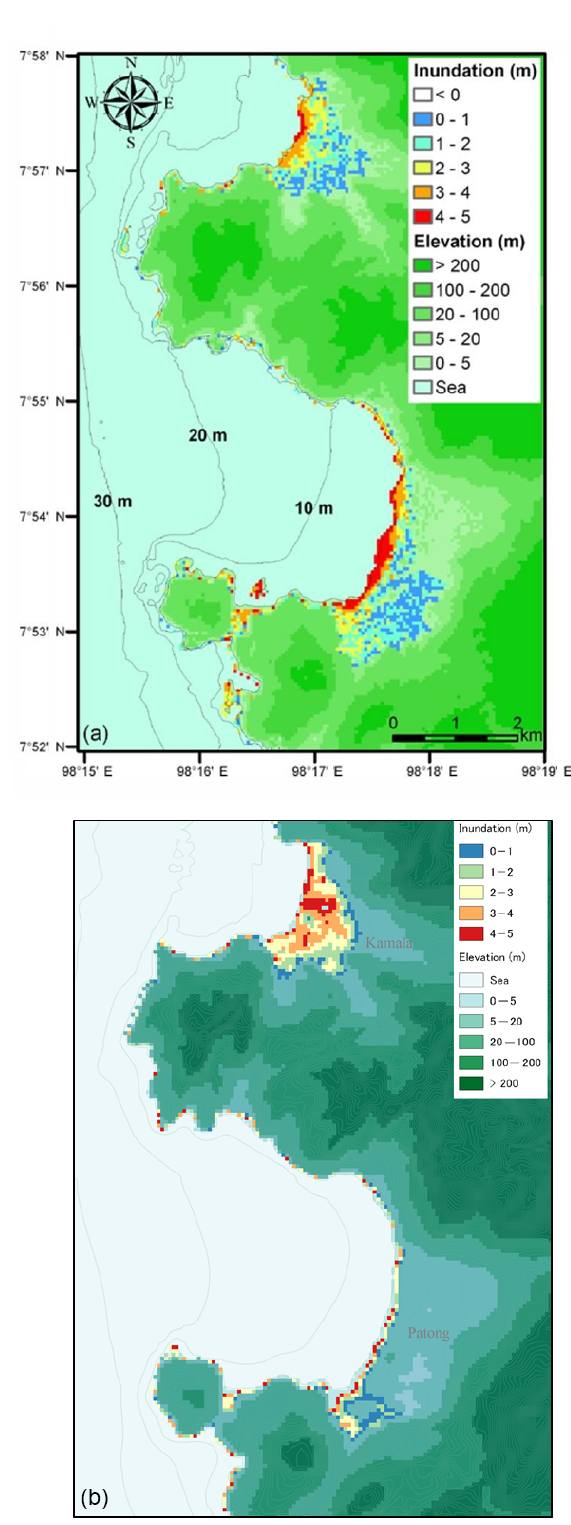
Figure 29. Kamala (north) and Patong (south) inundation maps comparison. (a) Inundation result by Supparsri et al. (2011). (b) TRITON-G inundation